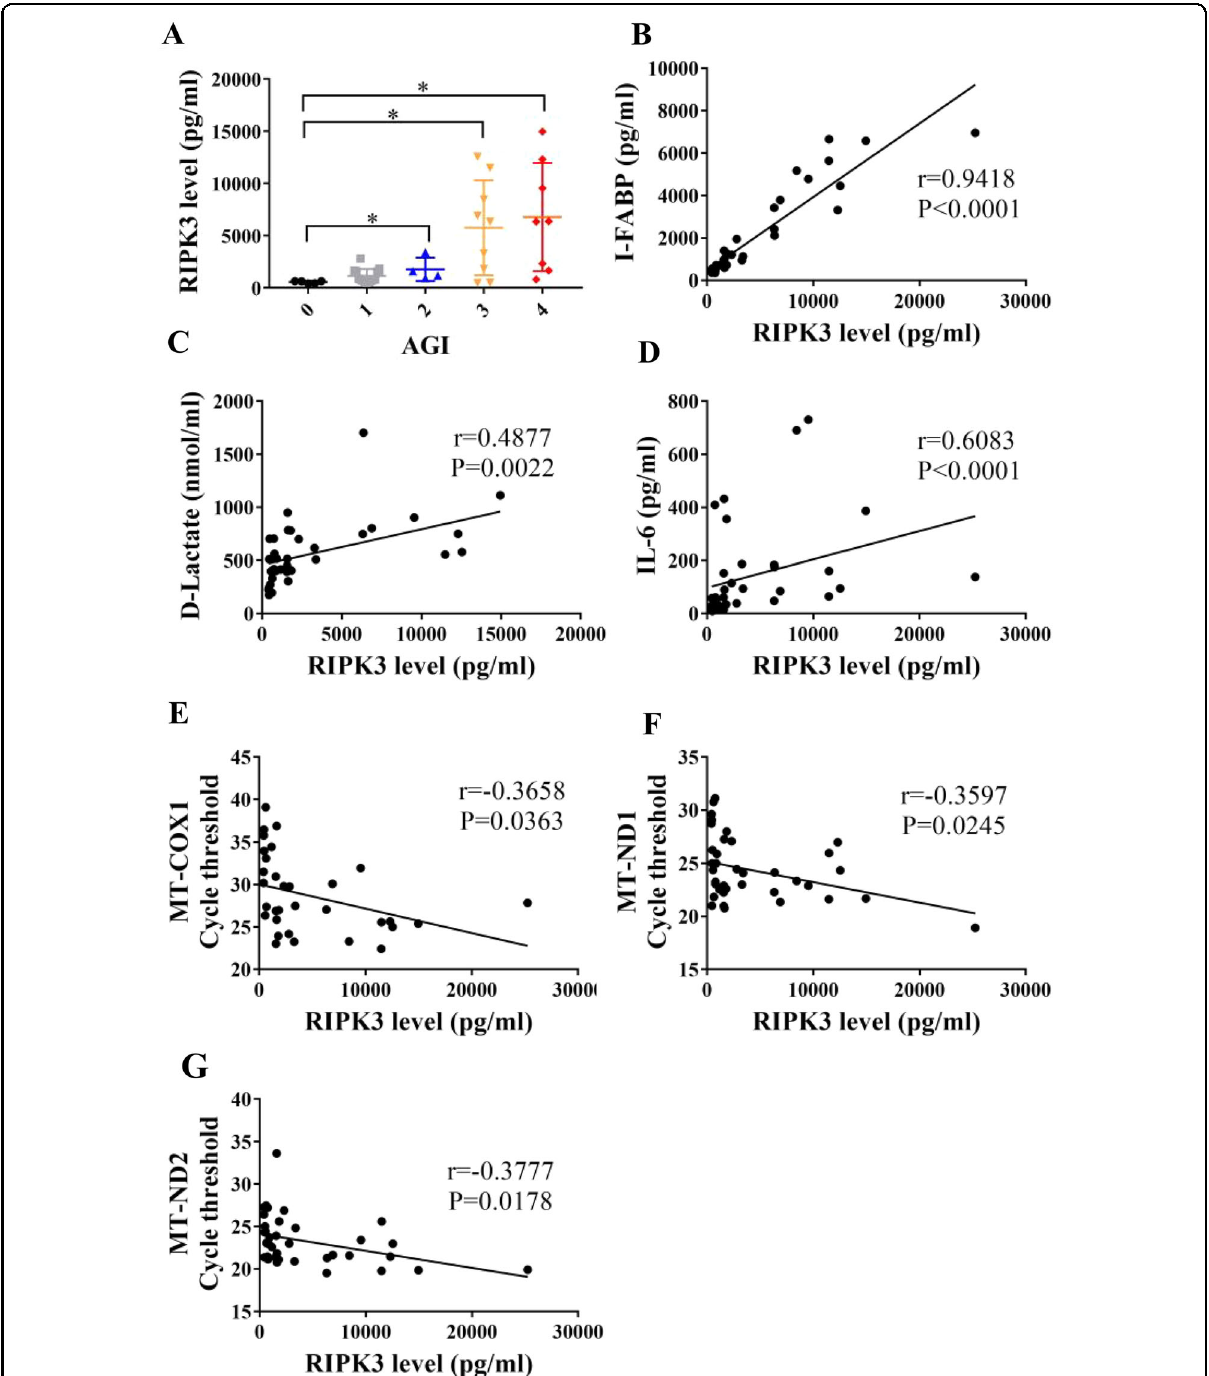
Fig. 1 Elevated serum RIPK3 is associated with intestinal injury in critically ill patients. ( A ) Circulating RIPK3 in critically ill patients with 1 – 4 of acute gastrointestinal injury (AGI) scores and healthy control (AGI score 0) was analyzed through enzyme-linked immunosorbent assay (ELISA). ( B – D ) Serum I-FABP, D-lactate, and IL-6 were assessed by ELISA. ( E – G ) Correlation between mtDNA and circulating was performed. mtDNA was analyzed via quantitative real-time PCR analysis by amplifying three kinds of mtDNA primers. * P < 0.05, ** P < 0.01 vs control